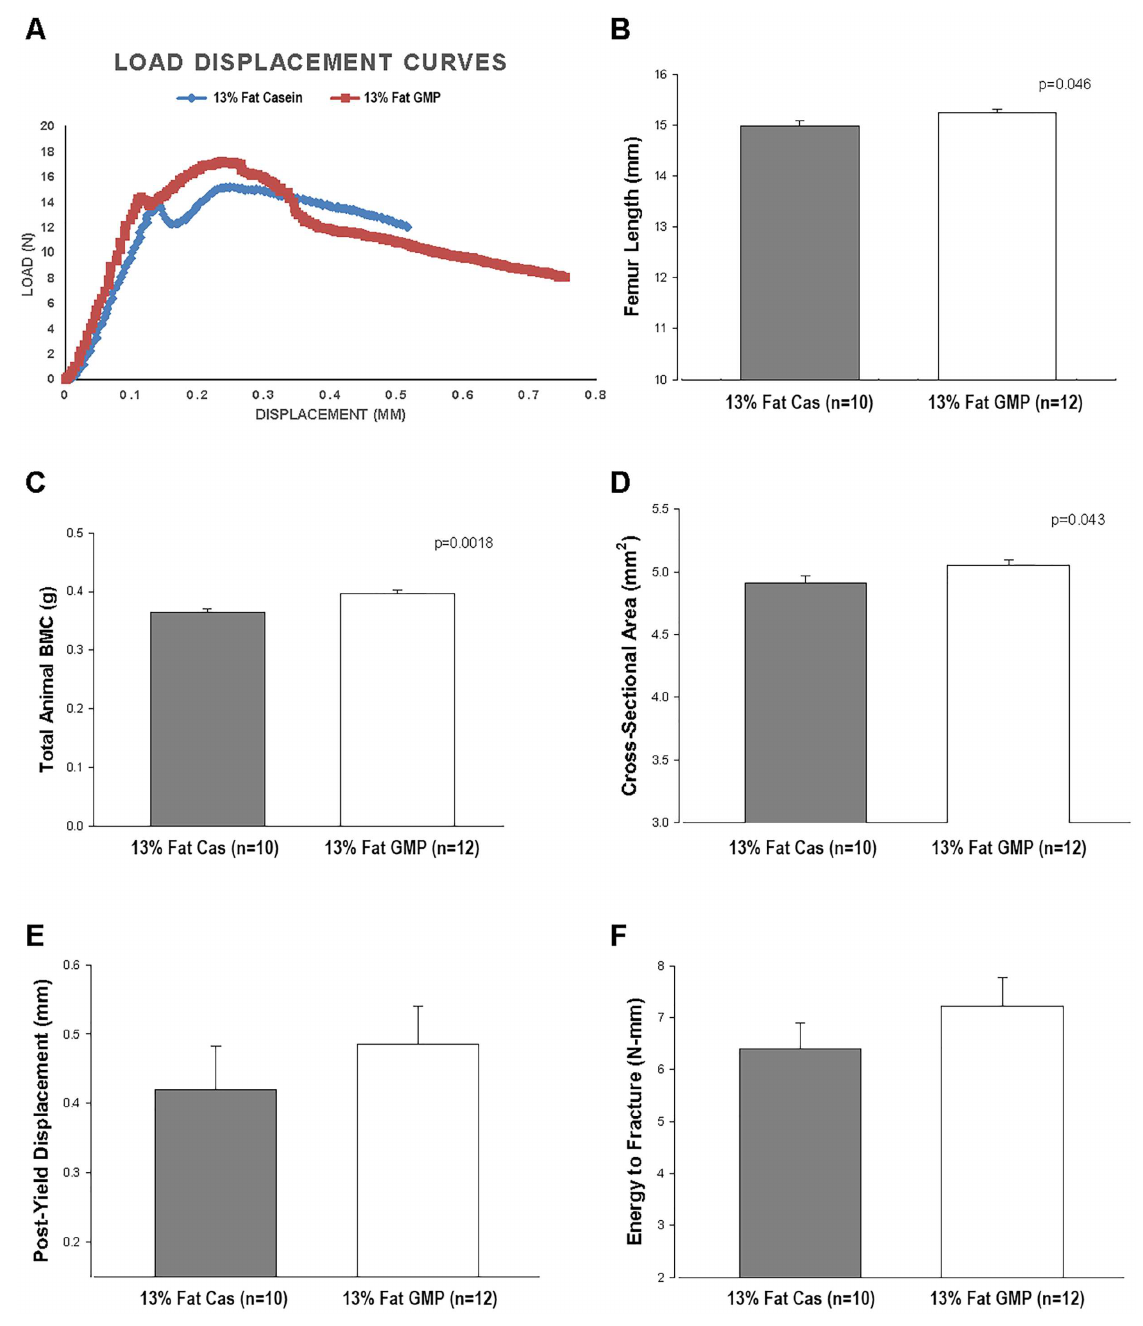
Fig 12. Bone measuresof mice fed 13%-fat casein and 13%-fat GMP diets. Representative load-displacement curves of female mice fed the 13%-fat casein and 13%-fat GMP diets (A). Effects in female mice fed 13%-fat casein and 13%-fat GMP diets for femur length (B), total animal BMC (C), cross-sectional area (D), post-yielddisplacement (E), and energy to fracture (F). Values are means ± SE; p-values represent main effect of fat. Sample size is shown in parenthesis. Mice fed the 13%-fat GMP diet had significantlyincreasedtotal animal BMC and femoral cross-sectional area and length comparedto mice fed the 13%-fat casein diet. Mice fed the 13%-fat GMP diet had increasedfemoral biomechanical performance values for post-yielddisplacement and energy to fracture compared to mice fed the 13%-fat casein